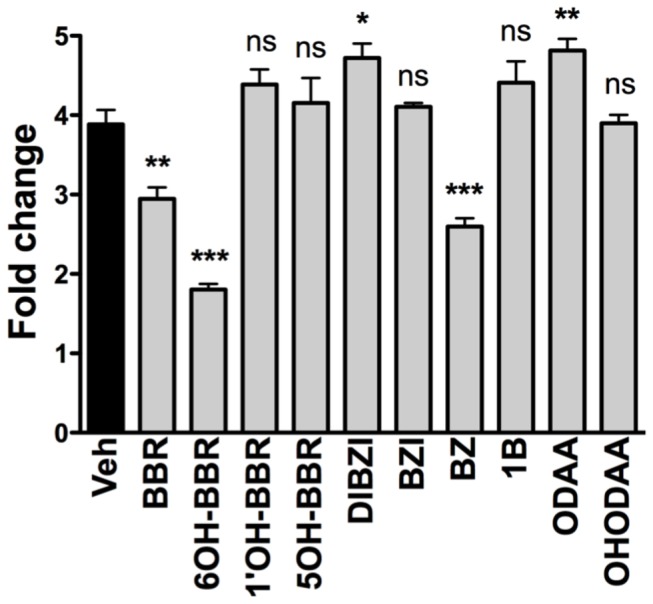
Proliferation of HUVECs in the presence of 7.5 μM test compounds.Cell viability was measured at 72 hours post-seeding. Asterisk represents significant differences between groups (*** P<0.001, * P<0.05).